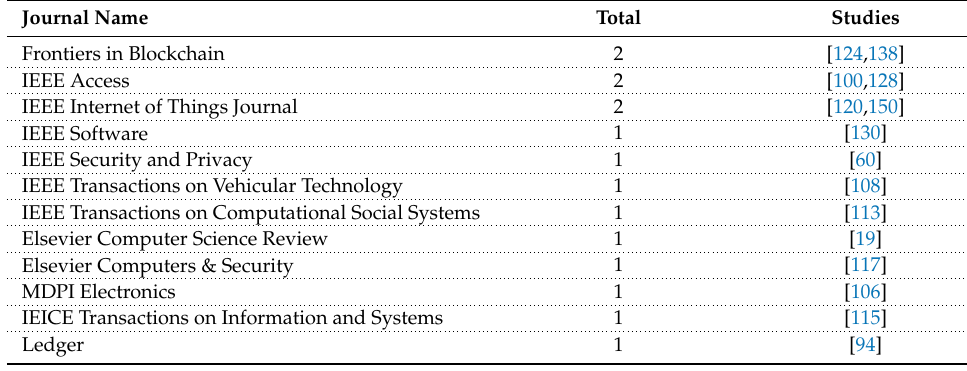
Table 11. Studies published in